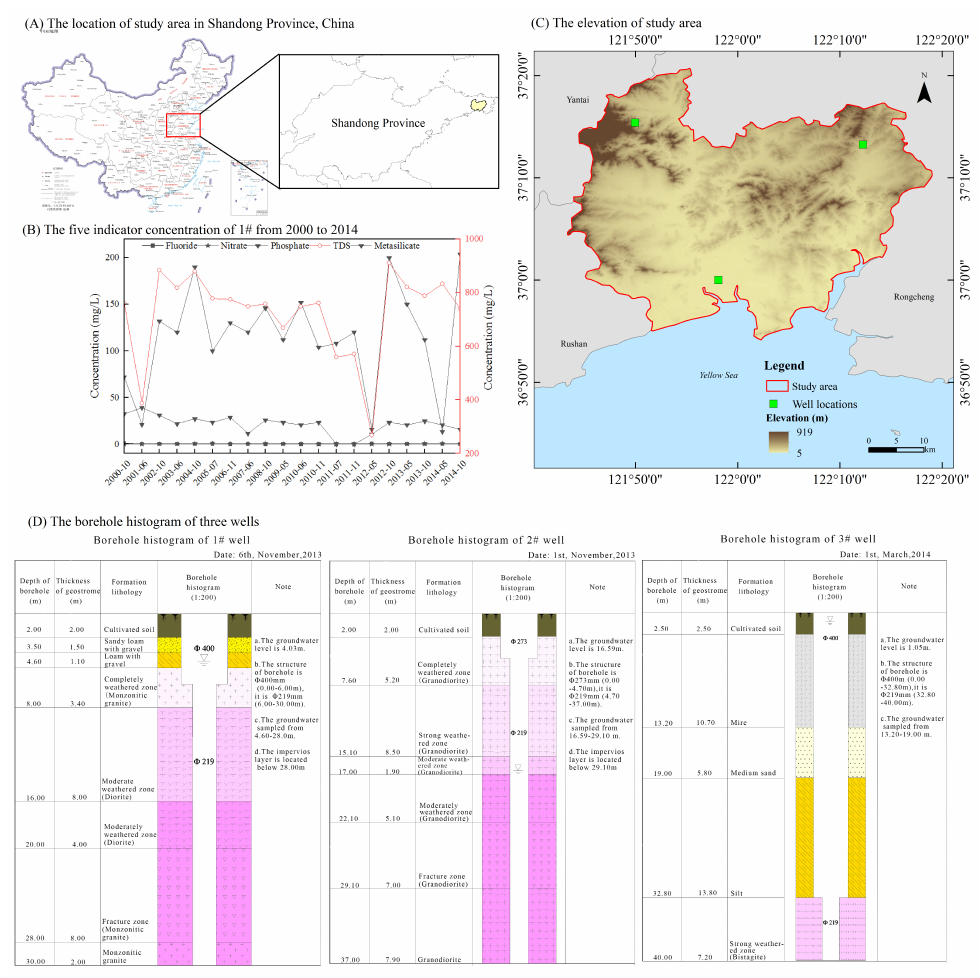
Figure 1. The basic information of study area and three